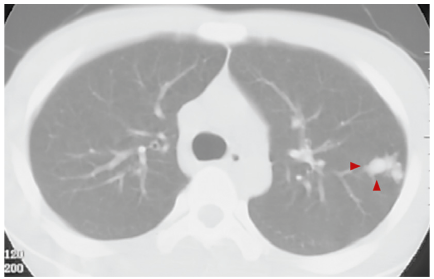
Figure 7: Four years after the treatment, coin lesion in the left upper lung appeared.